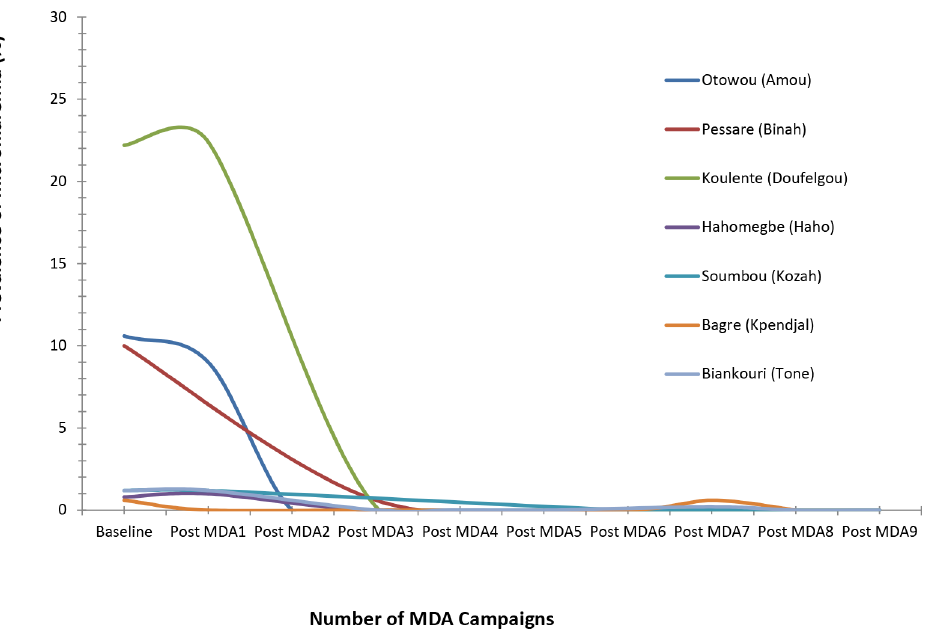
Figure 2. Progression of microfilaremia in sentinel sites in the endemic districts of Togo following subsequent mass drug administrations.